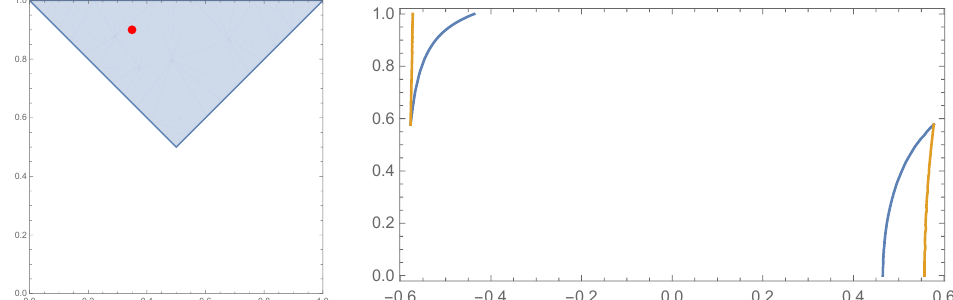
Fig. 6 (Left) triaxiality region with τ 1 = 0 . 35 and τ 2 = 0 . 9. (Right) Curves c σ 1 and c σ 2 restricted to interval [ 0 , 1 ] for ζ = 0 .